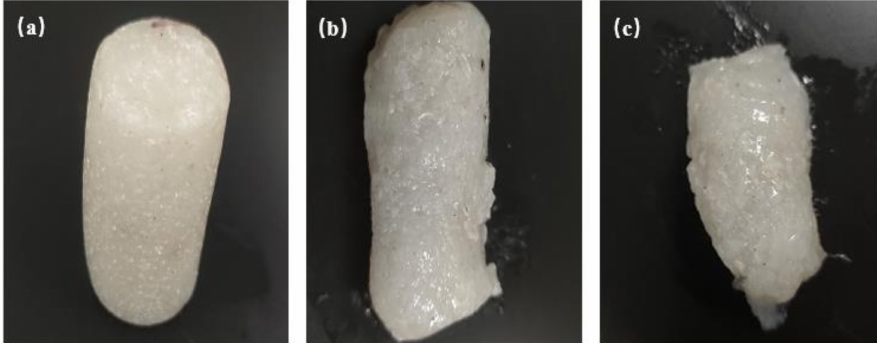
Figure 5. Gelation effect of gel system mixed with white oil: ( a ) Gel:white oil = 9:1; ( b ) gel:white oil = 8:2; ( c ) gel:white oil =